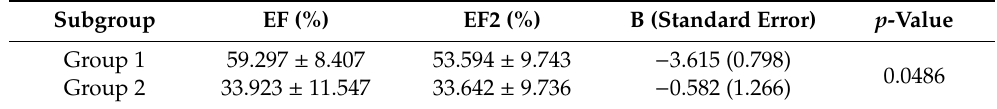
Table 4. The change value of the ejection fraction between Group 1 and Group 2 with linear mixed model analysis.